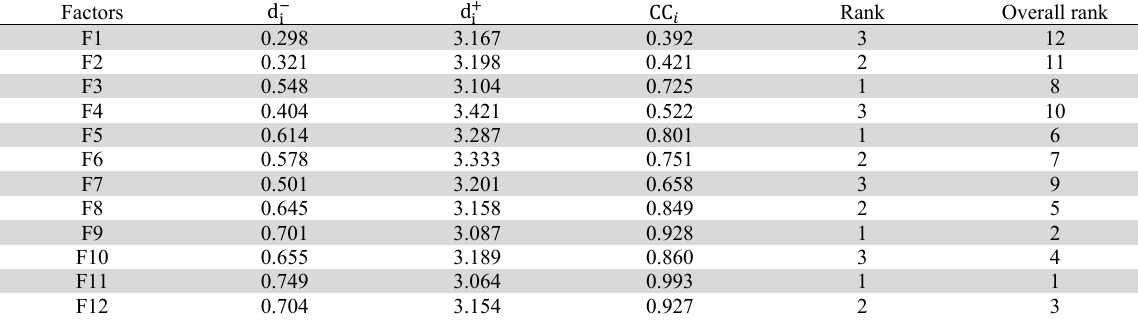
Final and overall ranking of factors for the decision-making